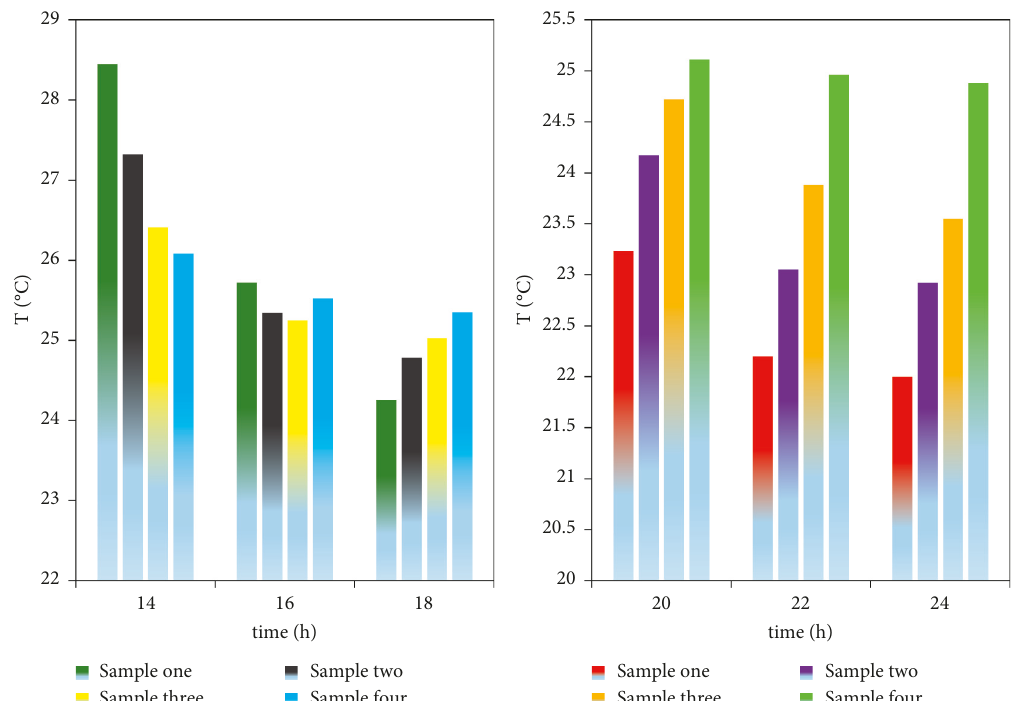
Figure 7: The temperature change diagram of the low temperature side when the samples of the east wall with different ratios release